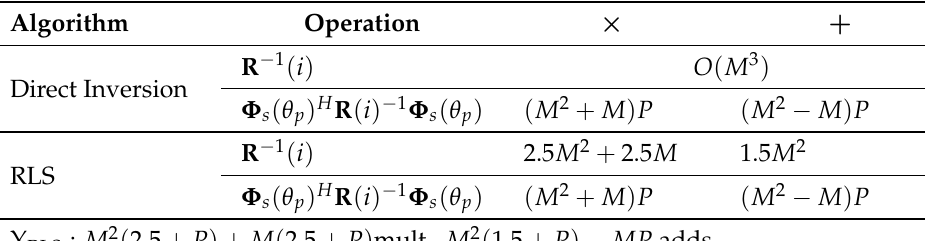
Table 3. Complexity comparison ( M